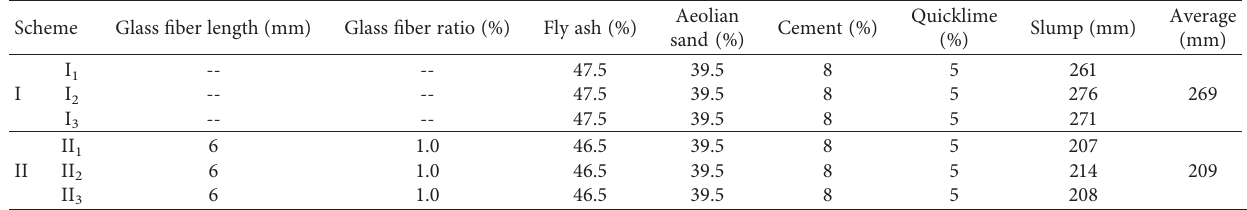
Table 4: Parameters of the slump testing of